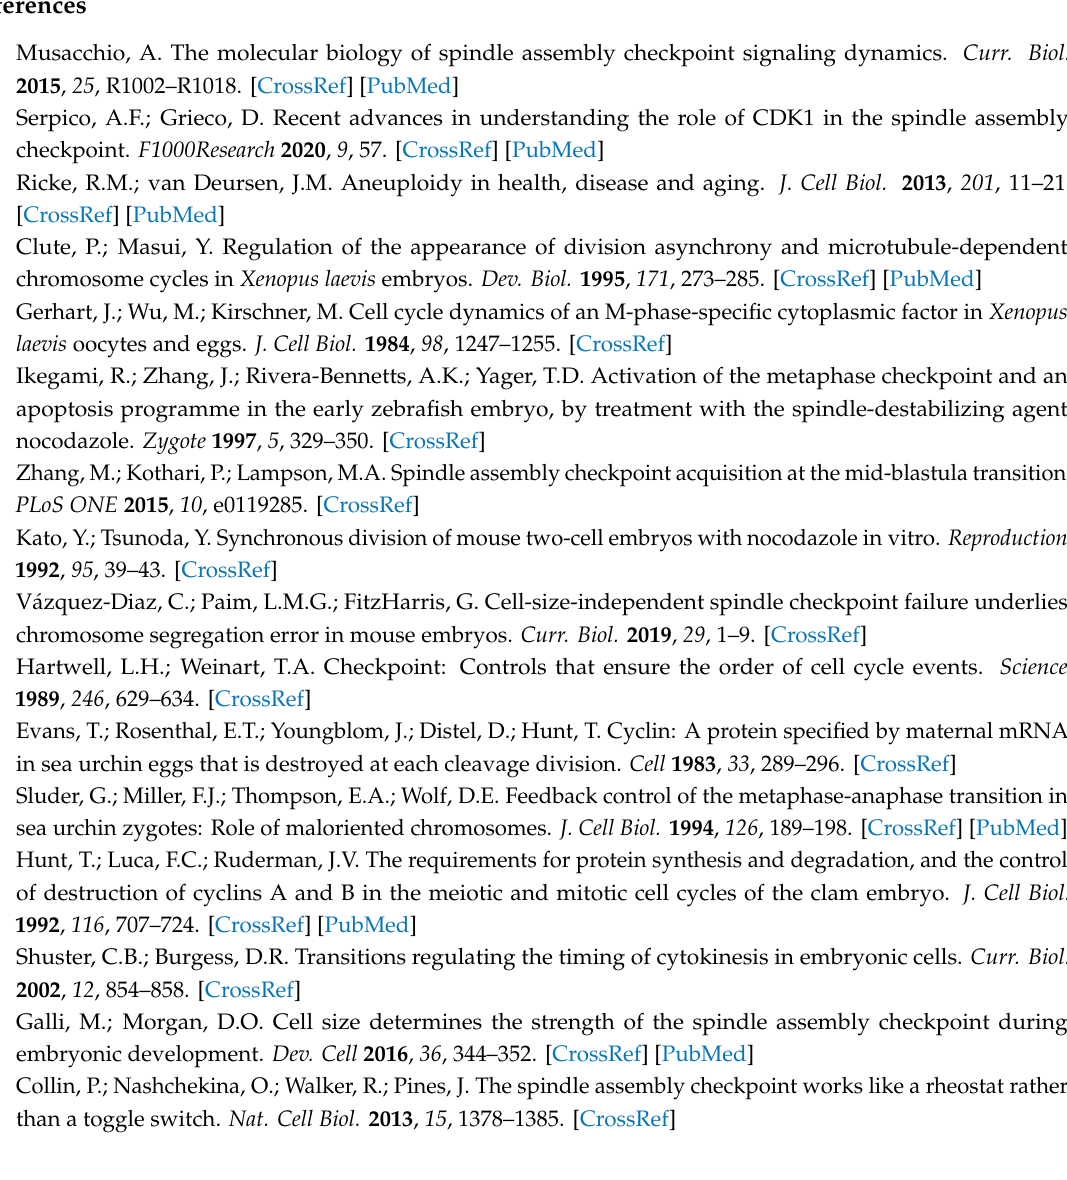
associated with Figure 3, Video S1: P. mammillata 2-cell embryos expressing H3B-Venus, in the presence of 10 µ M nocodazole, Video S2: P. lividus 2-cell embryos in the presence of 10 µ M nocodazole, Video S3: P. lividus 2-cell embryos in the presence of 10 µ M nocodazole and 0.5 µ M